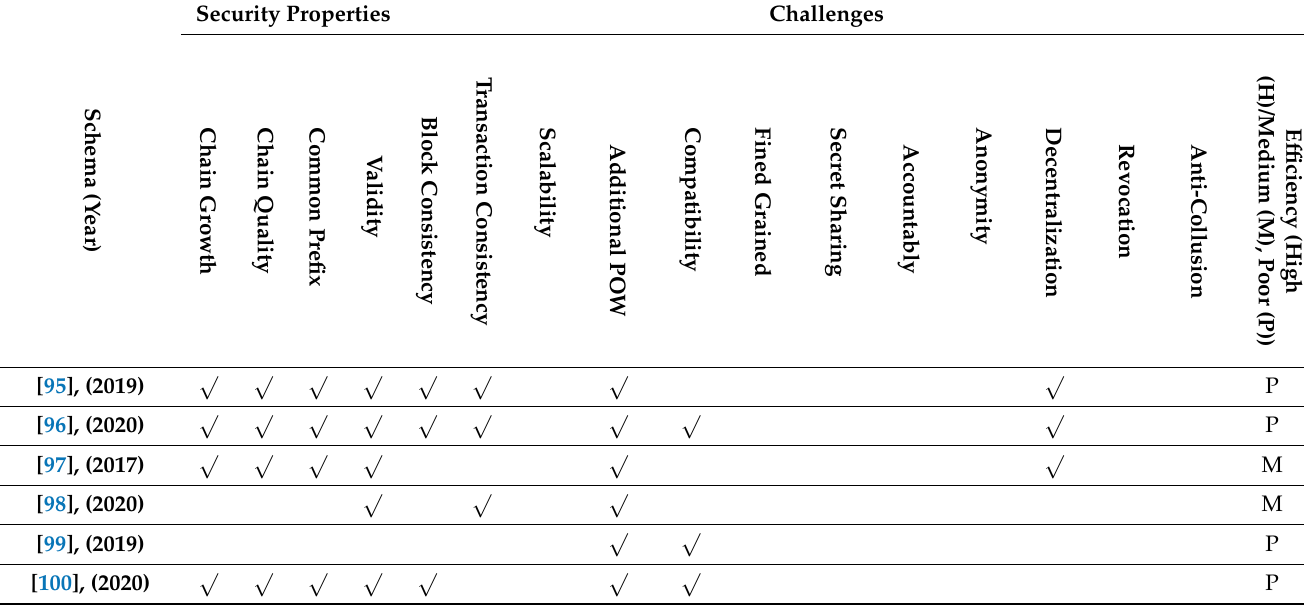
Table 5. Non-chameleon redaction approaches challenges